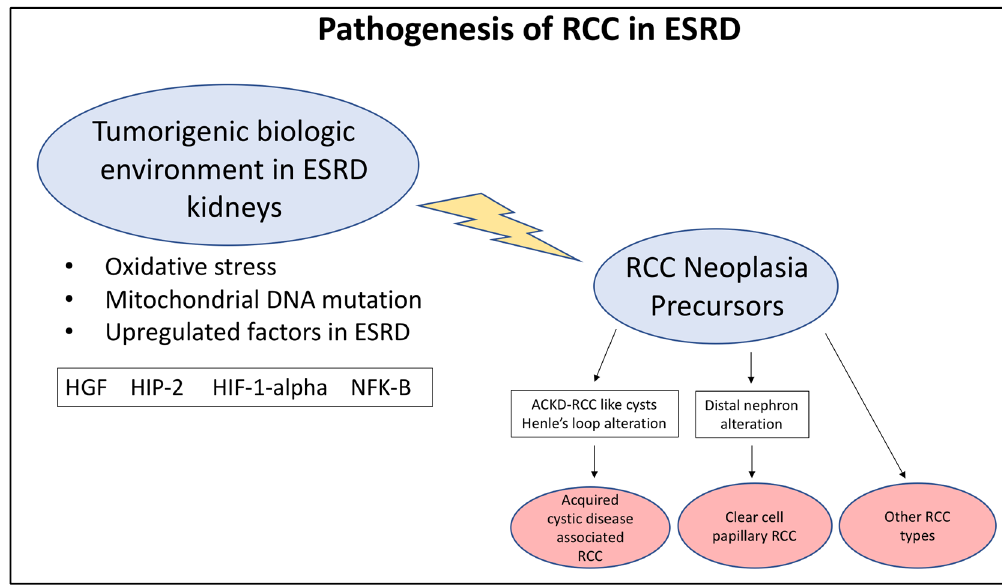
Figure 1. Summary of pathogenesis of RCC in ESRD.